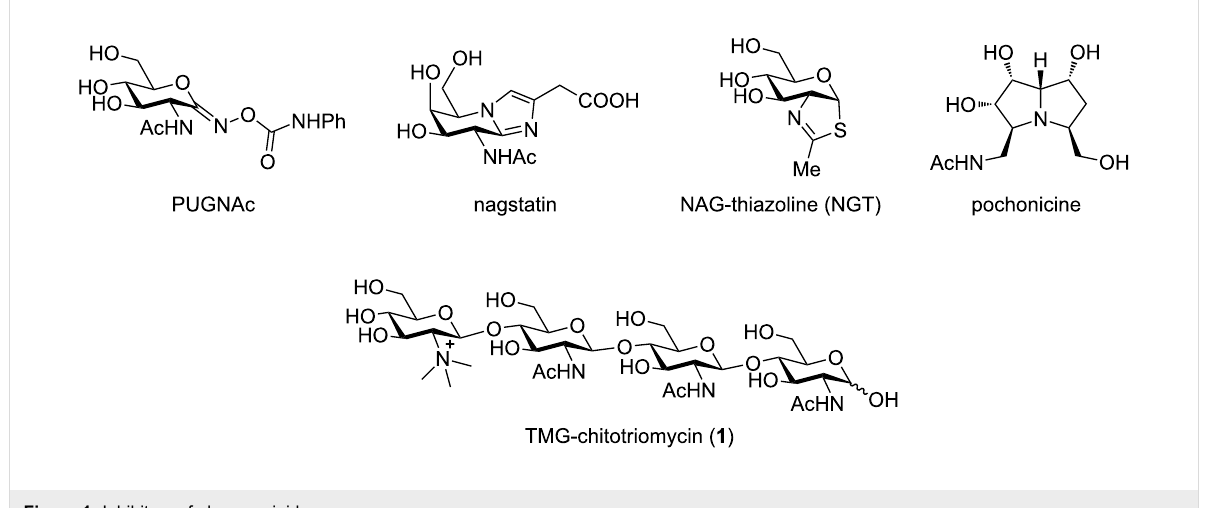
Figure 1: Inhibitors of glucosaminidases.